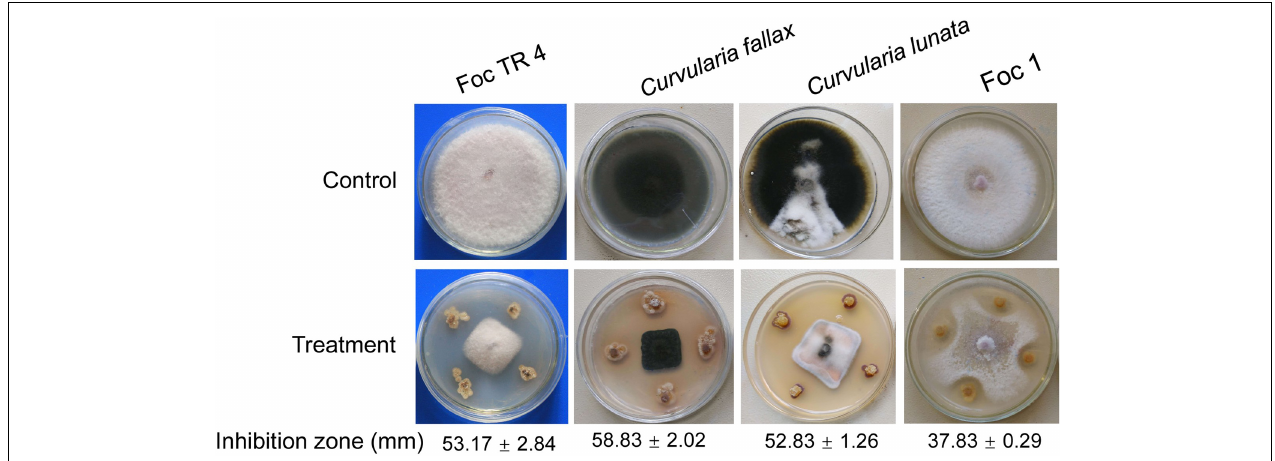
FIGURE 1 | Antifungal activity of strain SCA2-4 T against four banana fungal pathogens. Foc TR4: Fusarium oxysporum f. sp. cubense tropical race 4; Foc 1: Fusarium oxysporum f. sp. cubense